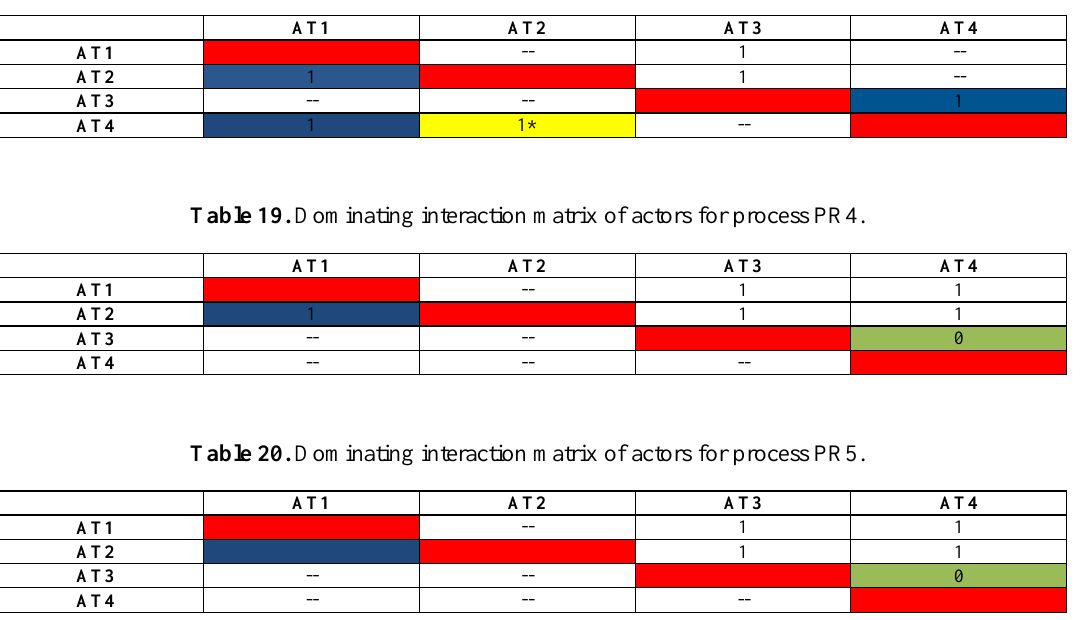
Table 18. Dominating interaction matrix of actors for process PR3.